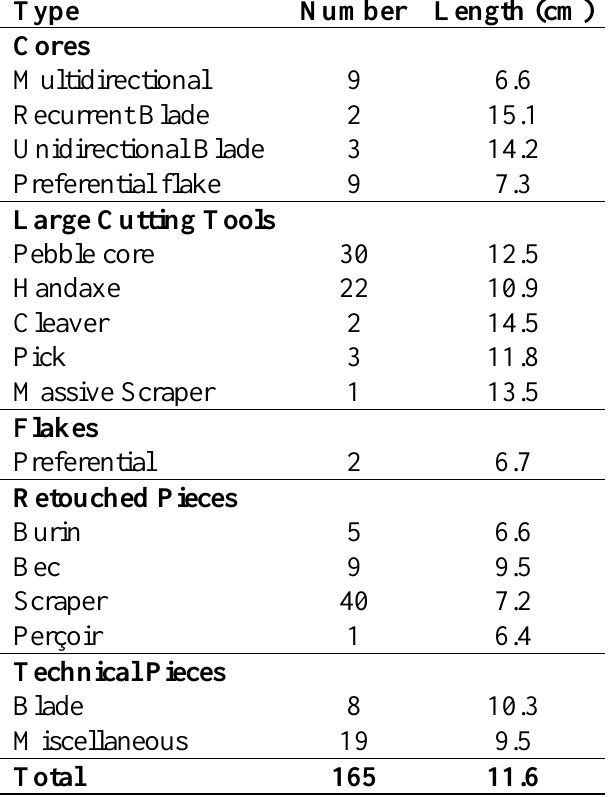
Table 1. The composition of the lithic collection in this